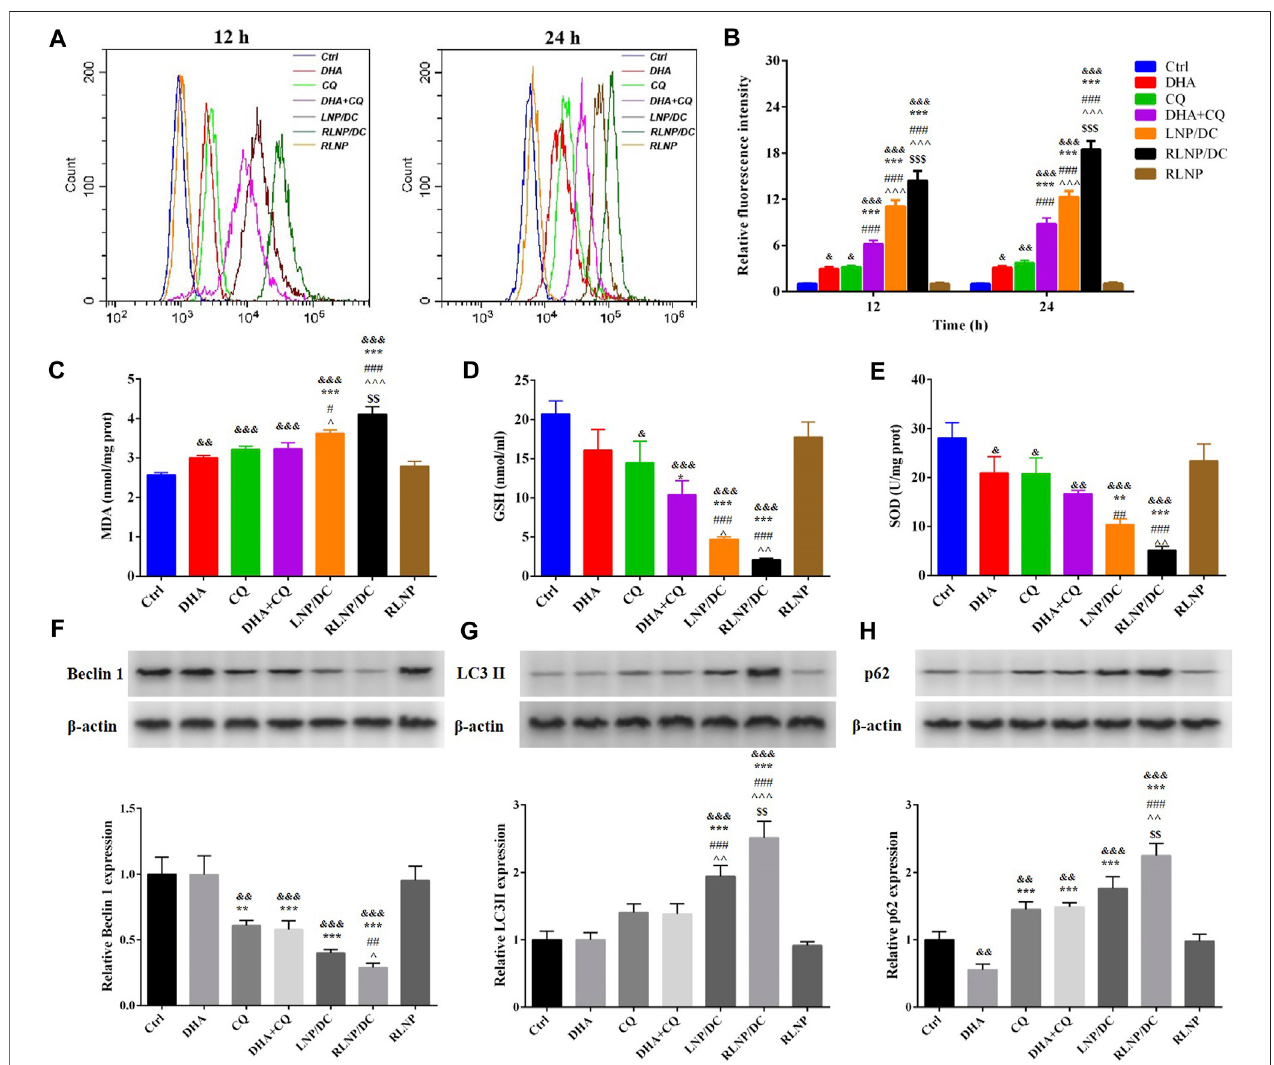
FIGURE 4 | Regulation of the intracellular ROS level and the underlying mechanism. (A, B) Quantitation ofintracellular ROS level of HCT116 cells after 12 and 24 h oftreatmentbyDHA,CQ,DHA+CQ,LNP/DC,RLNP/DC,andRLNP. (C – E) ThelevelofMDAandGSH,andSODactivityafter24 hoftreatment. (F,H) Expressionlevel of autophagy-related proteins including Becilin 1, LC3 II, and p62 after 24 h of treatment. Each bar represents the mean ± SD ( n (cid:1) 3). & p < 0.05, && p < 0.01, and &&& p < 0.001 vs. Ctrl; * p < 0.05, ** p < 0.01, and *** p < 0.001 vs. DHA; # p < 0.05, ## p < 0.01, and ### p < 0.001 vs. CQ; ^ p < 0.05, ^^^ p < 0.01, and ^^^^ p < 0.001 vs. DHA + CQ; $$ p < 0.01 and $$$ p < 0.001 vs.